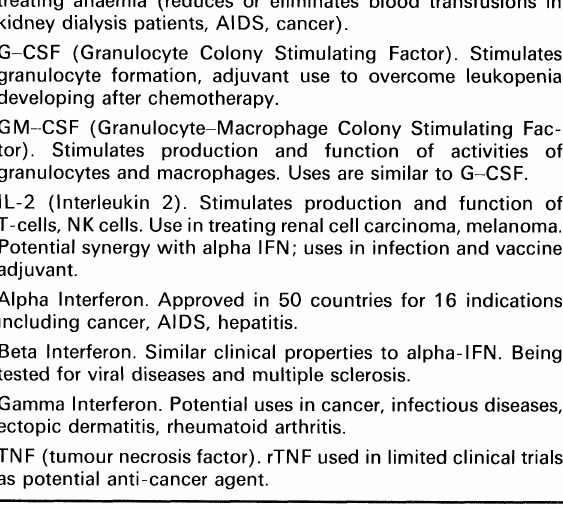
Table 14. Cytokines and their applications EPO (Erythropietin). Regulates RBC production. Used for treating anaemia (reduces or eliminates blood transfusions in kidney dialysis patients, AIDS, cancer).